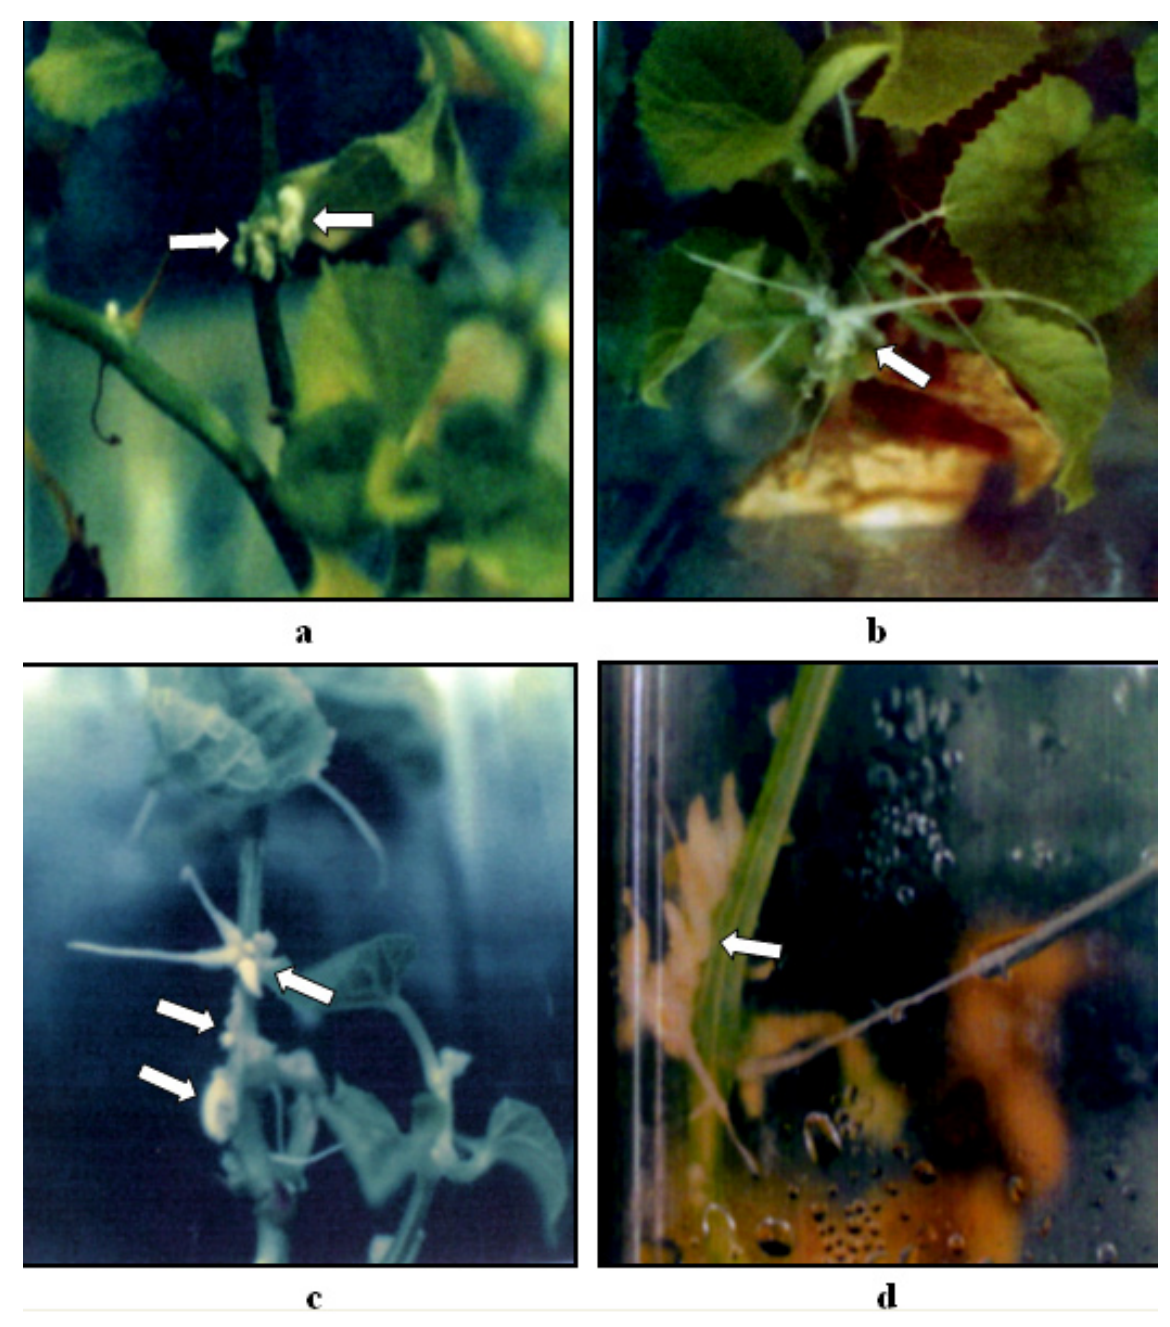
Fig. 12. Phenotypic expression of virulence gene of Agrobacterium in muskmelon: a) Crown galls initiated from wound site (stem) when infected with LBA 4404 strain; b) Hairy roots initiated from infected stem by A. rhizogenes strain A 105 at 39.3 μmol m -2 s -1 ; c) Hairy roots initiated when infected with A. rhizogenes strain 8196; d) Hairy roots instigated from stem vigorously when inoculated with A. rhizogenes strain 8196 in addition of acetosyringone at the concentration of 20